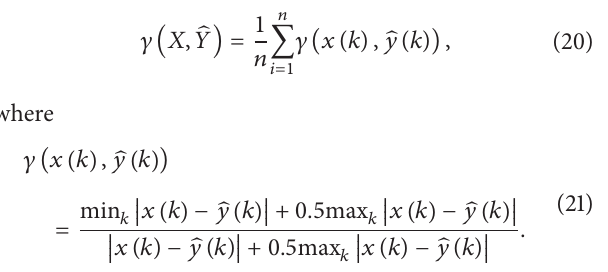
Figure 1: Time series plots of China’s energy consumption 2002–